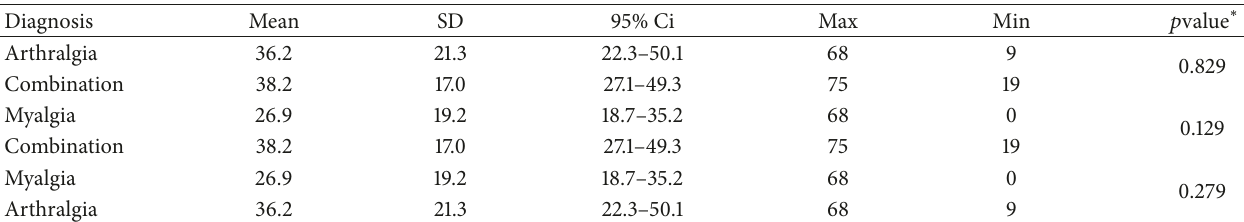
Table 3: Comparison of pain intensity using a VAS (0–100) for the diagnosis of myalgia, arthralgia, and a combination of both. Diagnosis Mean SD 95% Ci